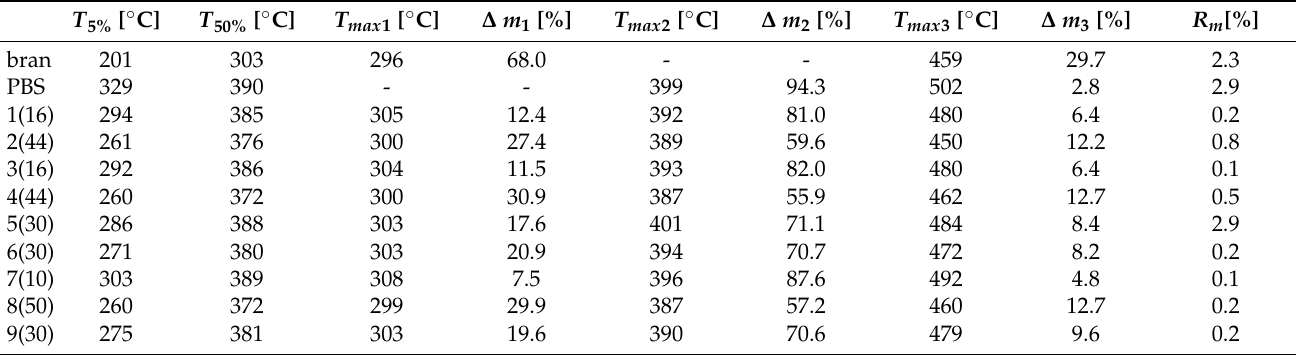
Table 8. Model of melt flow rate ( MFR ) – ANOVA table. R 2 = 0.99; R adj2 = 0.99. Source of Variation